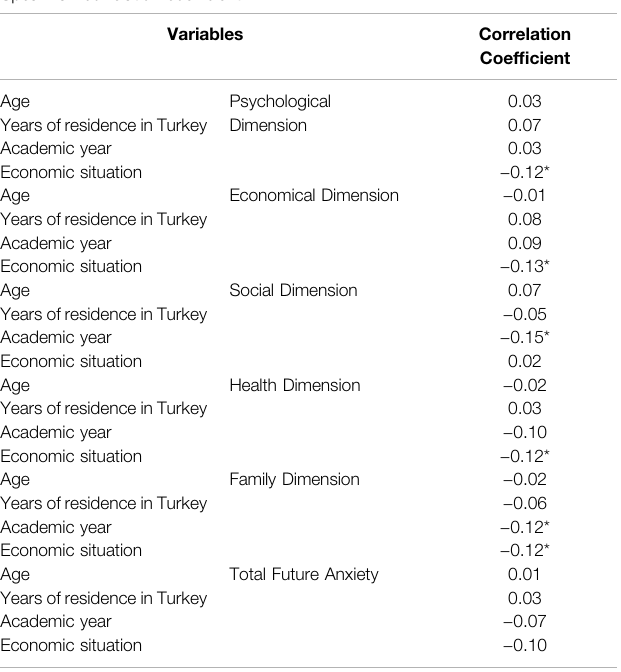
TABLE 2 | The below table show relationship between different demographical variables (ordinal variables), and various dimensions of future anxiety, using the Spearman correlation coef fi